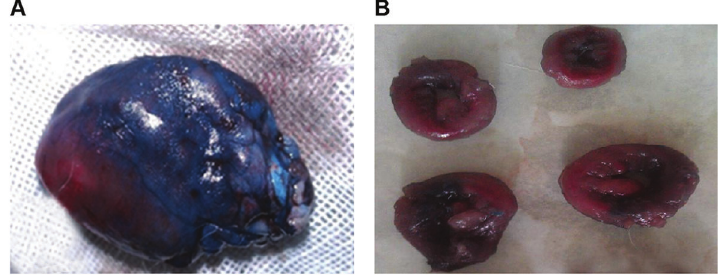
Figure 3. Evans Blue staining ( A ) and 2,3,5- triphenyl tetrazolium chloride (TTC) myocardium staining ( B ). Evans blue staining: blue color indi- cates normal myocardium and red color indicates ischemic myocardium; TTC myocardium staining: red color indicates ischemic myocardium and white color indicates myocardial